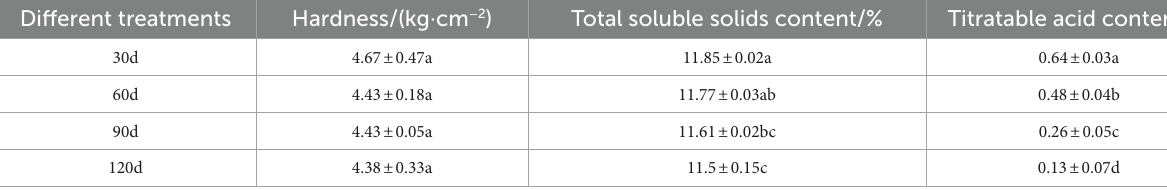
TABLE 2 Alpha diversity index of different treatments.